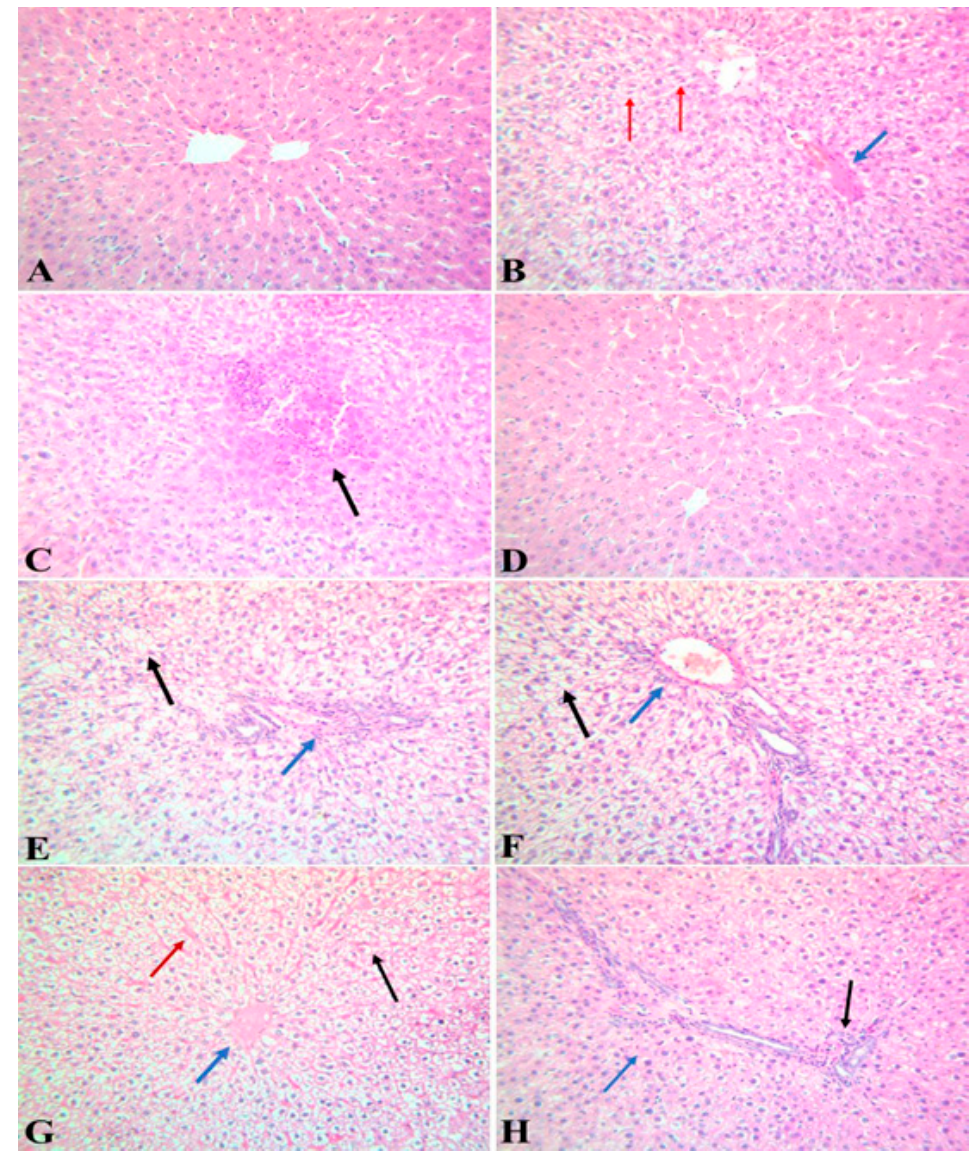
Figure 3. Photomicrographs of liver tissues sections of different groups stained with hematoxylin and eosin (H&E). ( A ) Liver tissue from rats of the control group showed a normal hepatic tissue structure; ( B , C ) hepatic tissues of rats from the lead acetate-intoxicated group showed congested blood vessels (blue arrow) and hepatic sinusoids, multiple areas of coagulative necrosis (black arrow) and mononuclear cell infiltrations, as well as the activation and proliferation of Kupffer cells (red arrow); ( D ) liver tissue of rats from the APE group showed normal hepatic tissue; ( E , F ) liver tissue of rats intoxicated with lead acetate and treated with APE showed congested blood vessels with perivascular infiltration (blue arrow), while the hepatocytes showed swelling and vacuolar degeneration (black arrow); ( G ) hepatic tissue of rats administrated with APE then intoxicated with lead acetate showed congested blood vessels (blue arrow) and hepatic sinusoids (red arrow) with vacuolation of hepatocytes (black arrow); ( H ) liver tissue of rats intoxicated with lead acetate then treated with APE showed congested blood vessels with perivascular infiltration (black arrow), while the hepatocytes showed single-cell necrosis (blue arrow) ( H and E × 40). The severity of the pathological findings was assessed by using a modified semiquantitative scoring system (- means no changes were present, + means mild changes, ++ means moderate and +++ means severe).